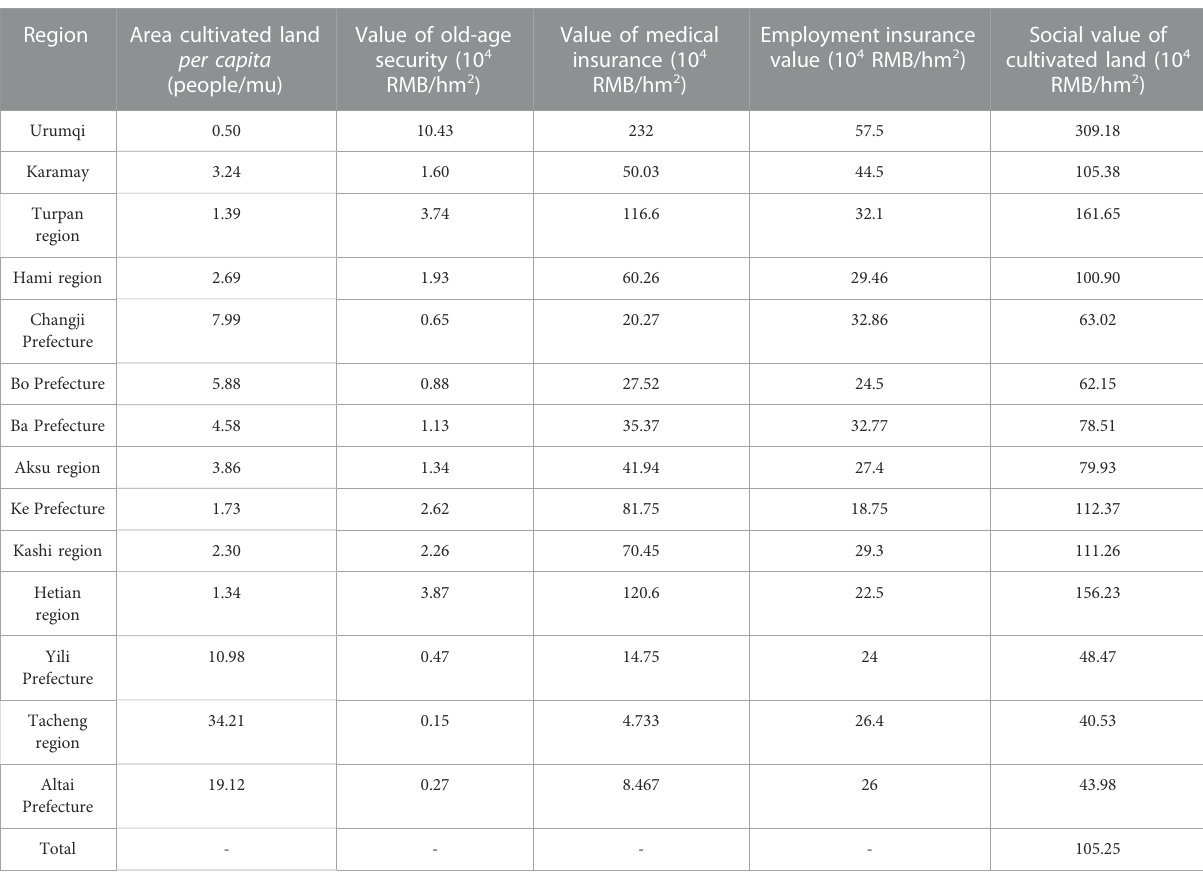
TABLE 4 Social value of the cultivated land in the state (city).